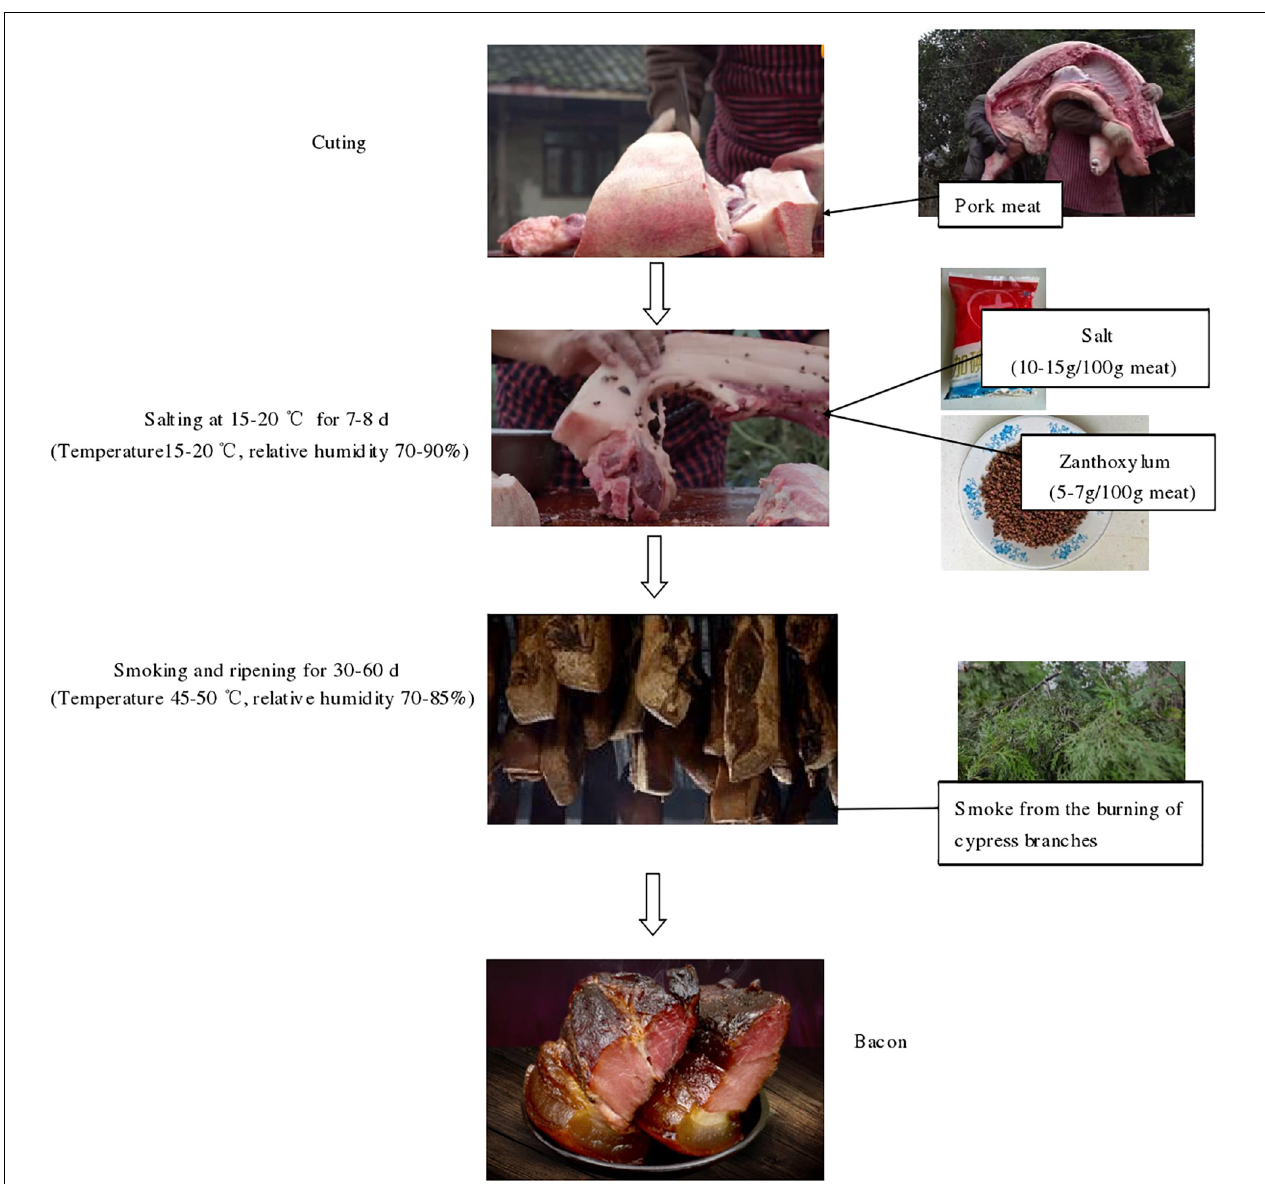
FIGURE 1 | A schematic diagram of the production of homemade pork